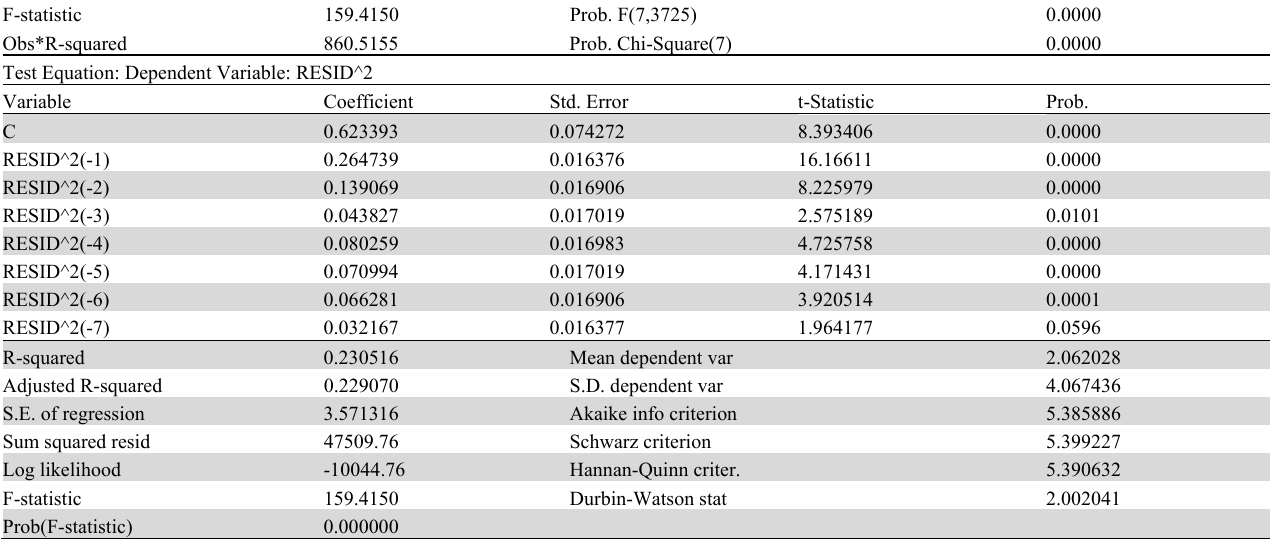
Results of the ARCH LM Test